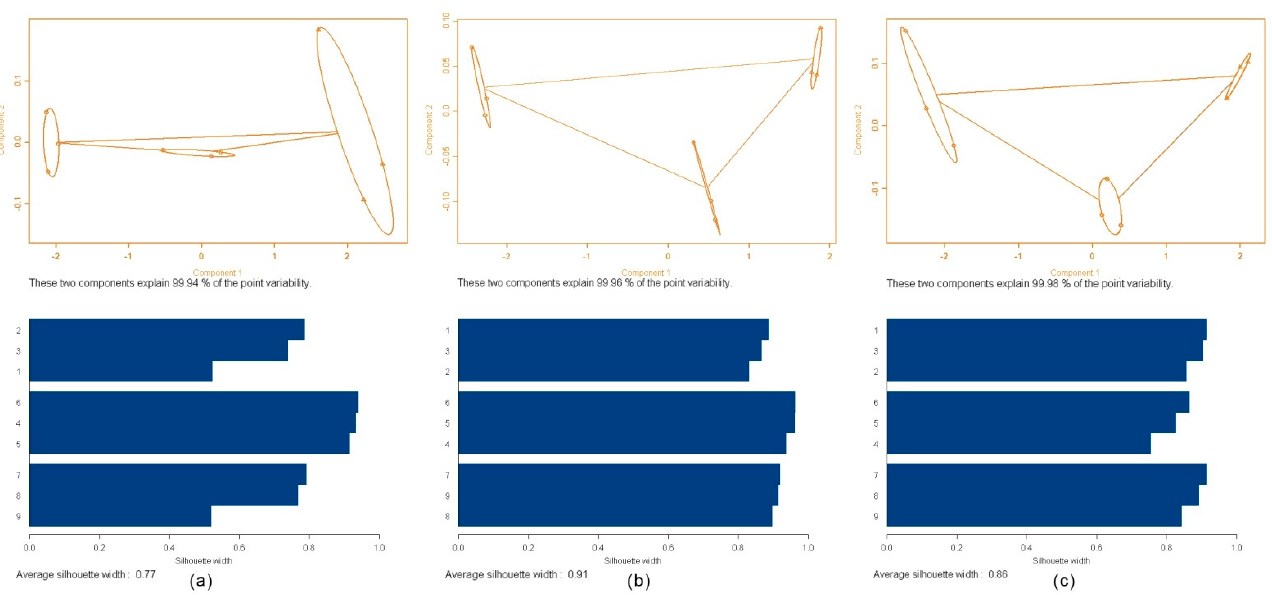
Figure 3. Classification of methyl, ethyl, and isopropyl alcohols by sensor array based on QCM sensors with hybrid ZnO-H 2 Pc, ZnO-CuPc, and ZnO-PbPc layers; ( a ) without illumination; ( b ) under illumination in 472 nm region; ( c ) under illumination in 615 nm region.